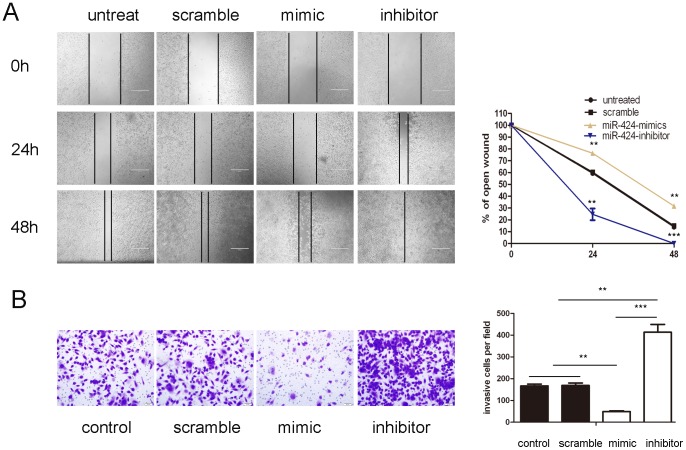
Ectopic expression of miR-424 suppressed HCC cell migration and invasion.(A) Wound healing assays of HepG2 cells after treatment with miRNA mimics, inhibitors or scramble or no transfection; the relative ratio of wound closure per field is shown. (B) Transwell analysis of HepG2 cells after treatment with miRNA mimics, inhibitors or scramble or no transfection; the relative ratio of invasive cells per field is shown below, ** p<0.01, and ***p<0.001.